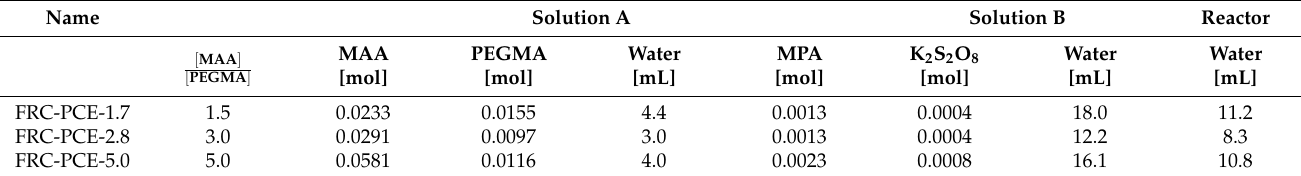
Table A1. Applied chemicals for free radical copolymerization of PCEs with different grafting